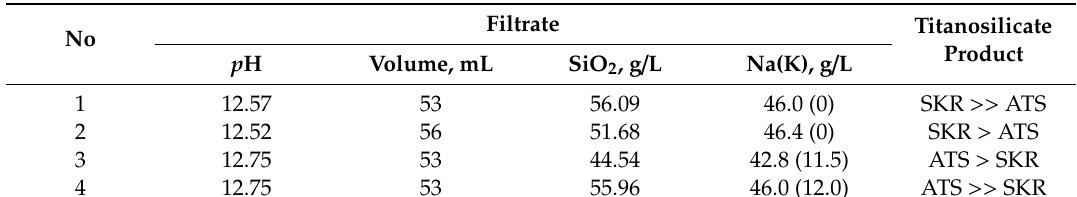
Table 2. Results of SKR synthesis.